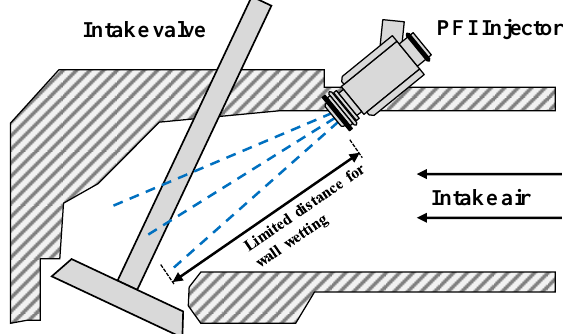
Figure 8. Schematic diagram of intake port in PFI system and definition of limited distance for wall wetting.